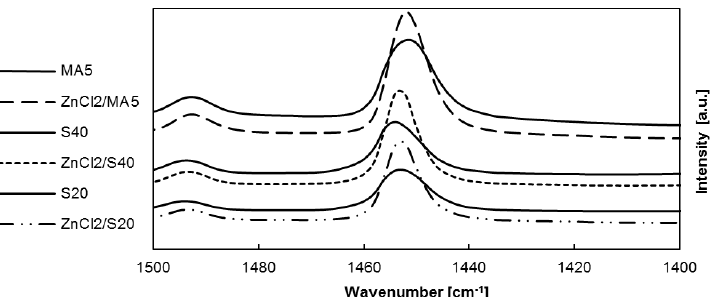
Figure 6. Comparison of Lewis acidity of the materials MA 5, Siral 40, Siral 20 and their ZnCl modified forms (5 mg MTO/100 mg support). 2